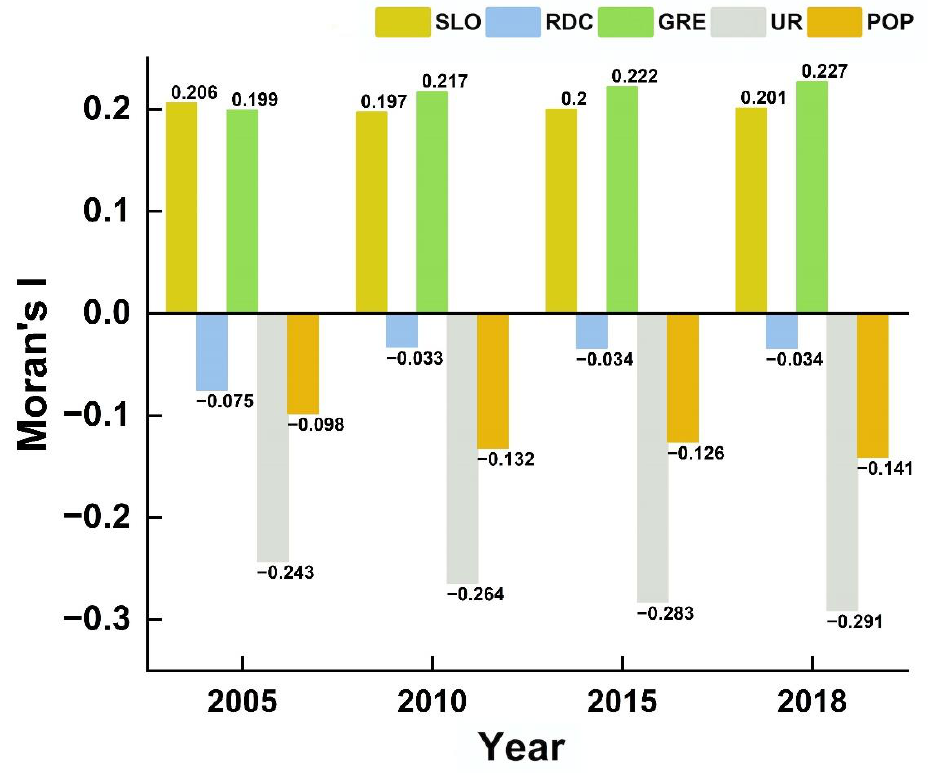
Figure 5. Global Bivariate Moran’s I between ESV and five factors in 2005, 2010, 2015, and 2018. SLO, slope; RDC, river distance accessibility; GRE, per capita green area; UR, the proportion of urban and rural human settlements; POP, population.